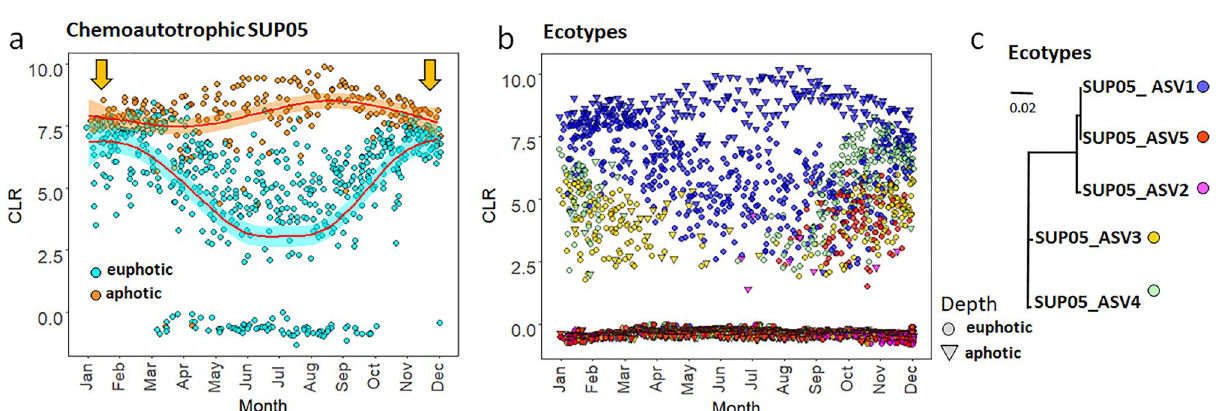
Figure 8. Seasonal trends for the chemoautotrophic SUP05 lineage in the Bedford Basin from 2014–2017. The SUP05 reads are conglomerated at a genus level ( a ) to highlight the differences between the euphotic and aphotic zones, while ( b) highlights the different SUP05 ecotypes from non-conglomerated reads. Winter mixing occurs during Nov-Feb shown by orange arrows on ( a ). Generalized additive mode smoothings are shown in red ( a ), note: analysis of CLR data reveals how ASVs behave relative to the per-sample average. Sampling depths are presented by different symbols on ( b ), and ecotypes are shown in different colours. The red arrow ( b ) highlights the temporal niche for ecotype SUP05_ASV5 . Neighbor-Joining tree with a Tamura-Nei genetic distance model for the five SUP05 ecotypes ( c